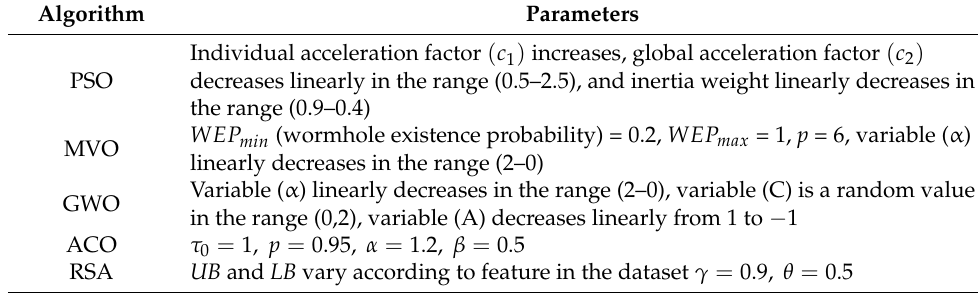
Table 2. Parameter settings. Algorithm